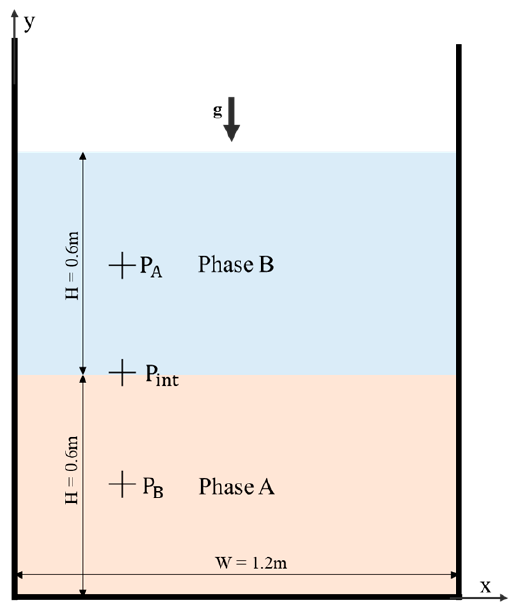
Figure 7. Initial setup of the static tank test. Table 1. Physical and rheological parameters used in static tank test.